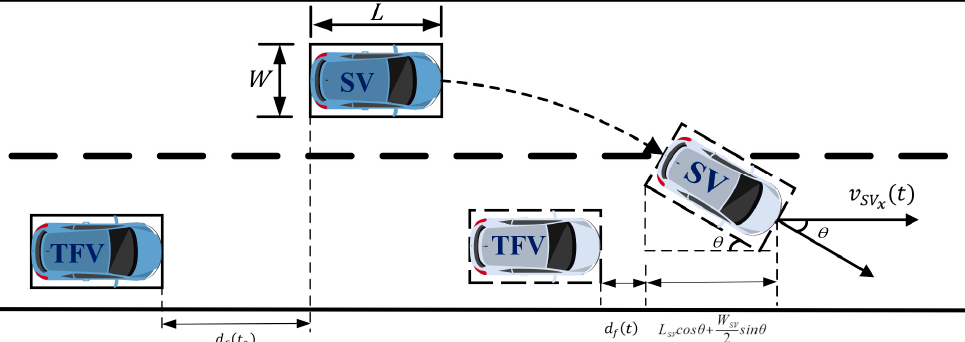
Figure 3. Insertable gab between SV and TFV .